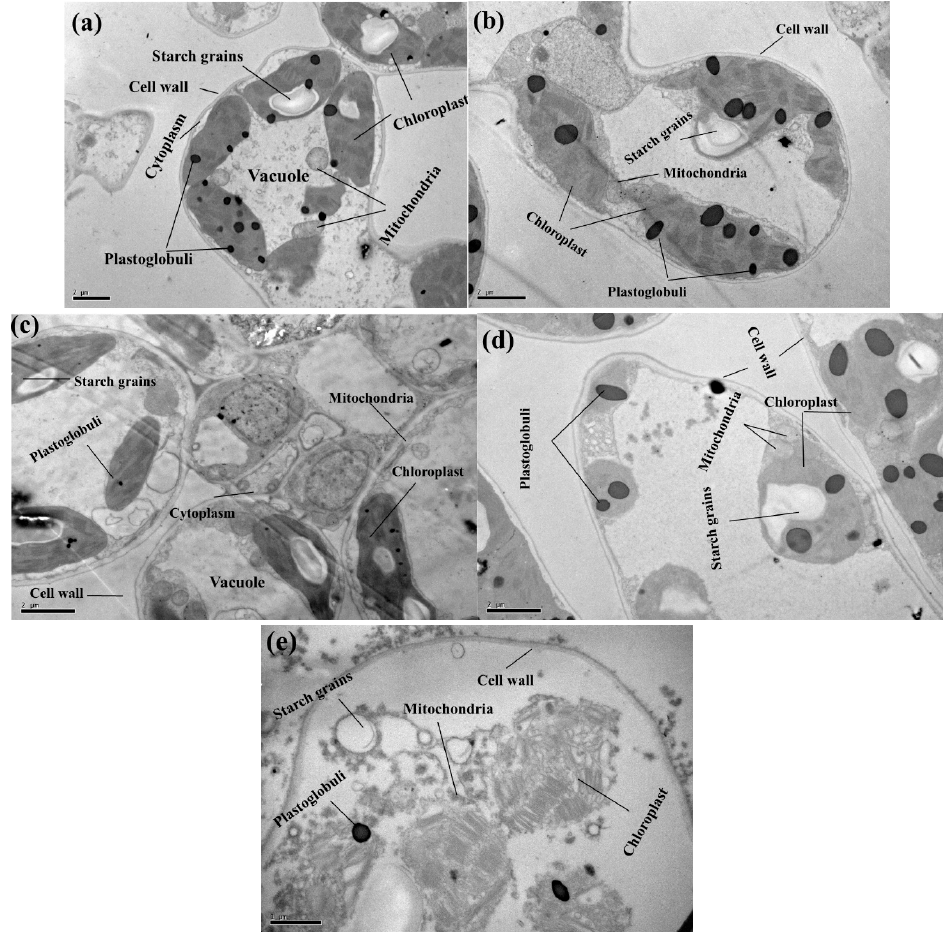
Figure 6. TEM photos of C. capsularis leaf cells ( a ) Ck (soil without addition of Cu-contaminated